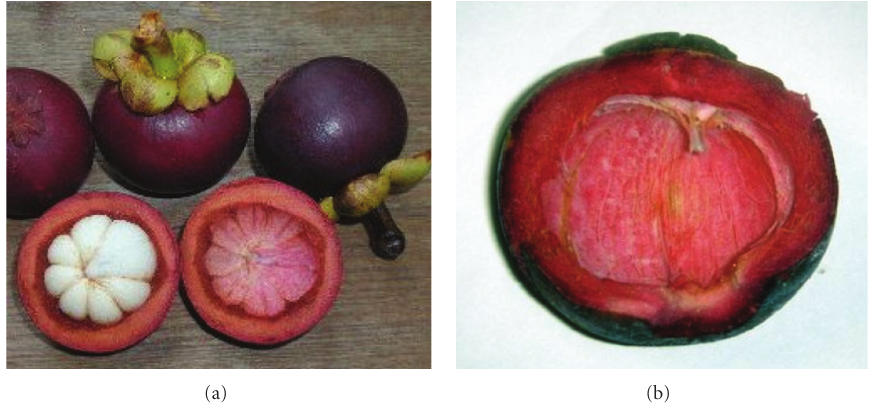
Figure 1: (a) Mangostana fruit. (b) Pericarp.